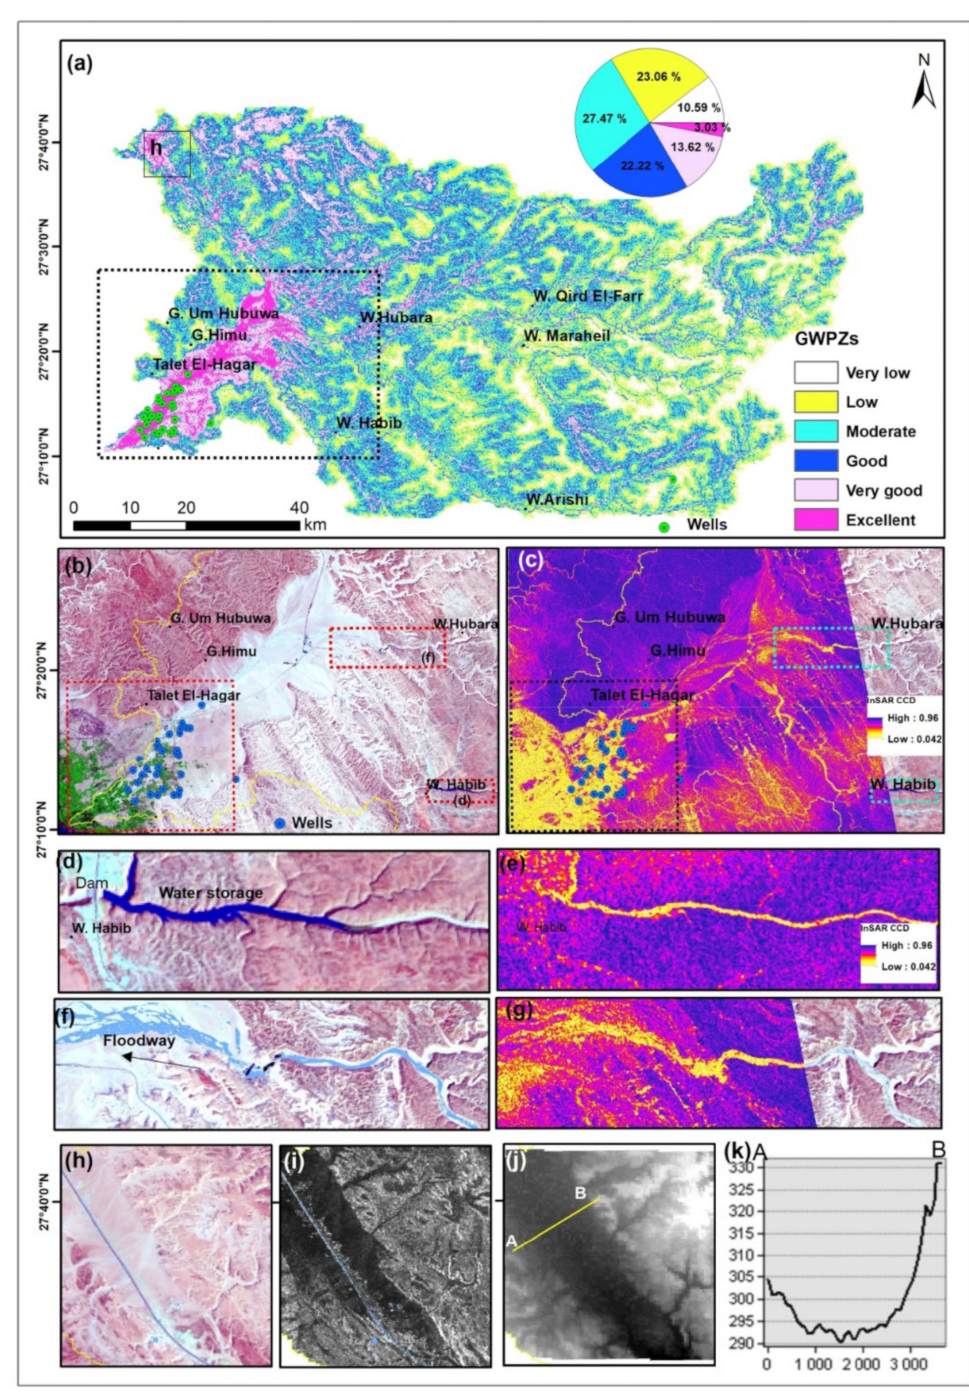
Figure 8. GWPZs ( a ) GWPZs overlaid by well data in the downstream area; ( b ) Landsat data in the downstream area overlaid by wells that are presented in blue points; ( c ) InSAR CCD data for the downstream area; ( d ) Landsat image display water accumulation in blue color behind a dam; ( e ) InSAR CCD same as area in ( d ). ( f ) extracted floodway marked in light blue derived from the NDVI of the OLI image from 2014; ( g ) InSAR CCD data for February 2015 to February 2017; ( h ) subset of Landsat image as indicated subfigure ( a ); ( i ) ALOS/PALSAR display alluvial deposits in dark tone; ( j ) DEM, and elevation profile A–B; ( k ) elevation profile reveal the topographic characteristics of the